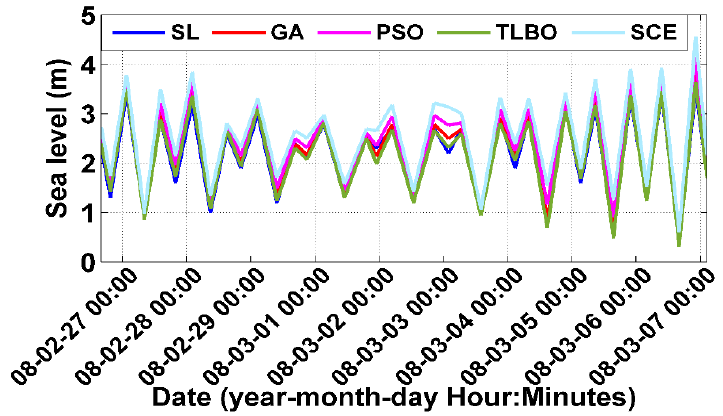
Figure 4. SLH at Rajaei tide gauge station using different optimization methods. Figure 5. Correlations between the observations of the SLH at the Rajaei tide gauge station and the model output in three cases: ( a ) before data assimilation, ( b ) after data assimilation without consid ‐ ering the variance–covariance matrices, and ( c ) considering the variance–covariance matrices .